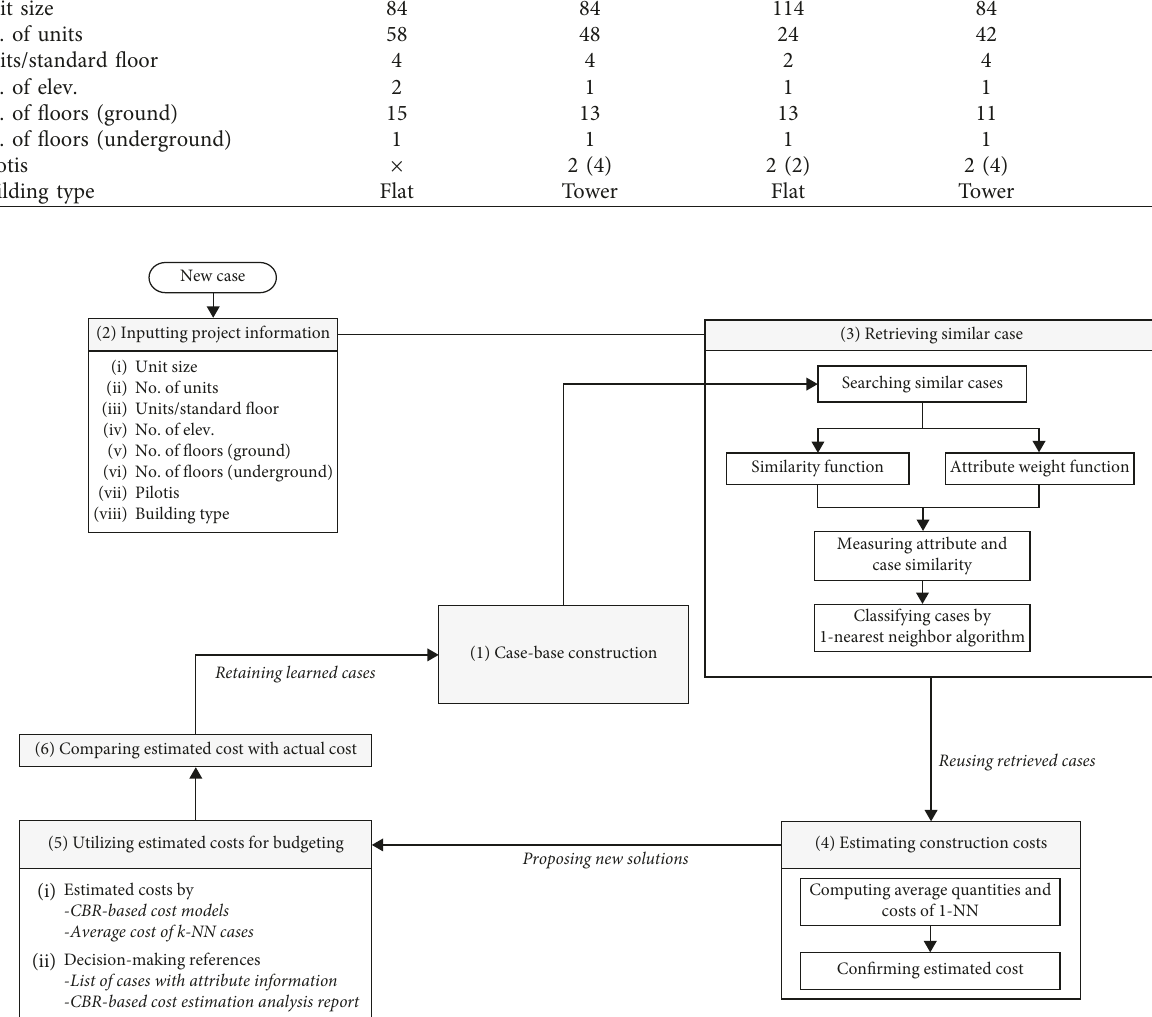
Figure 6: The CBR-based cost estimation procedures for validation (revised from Ahn et al.